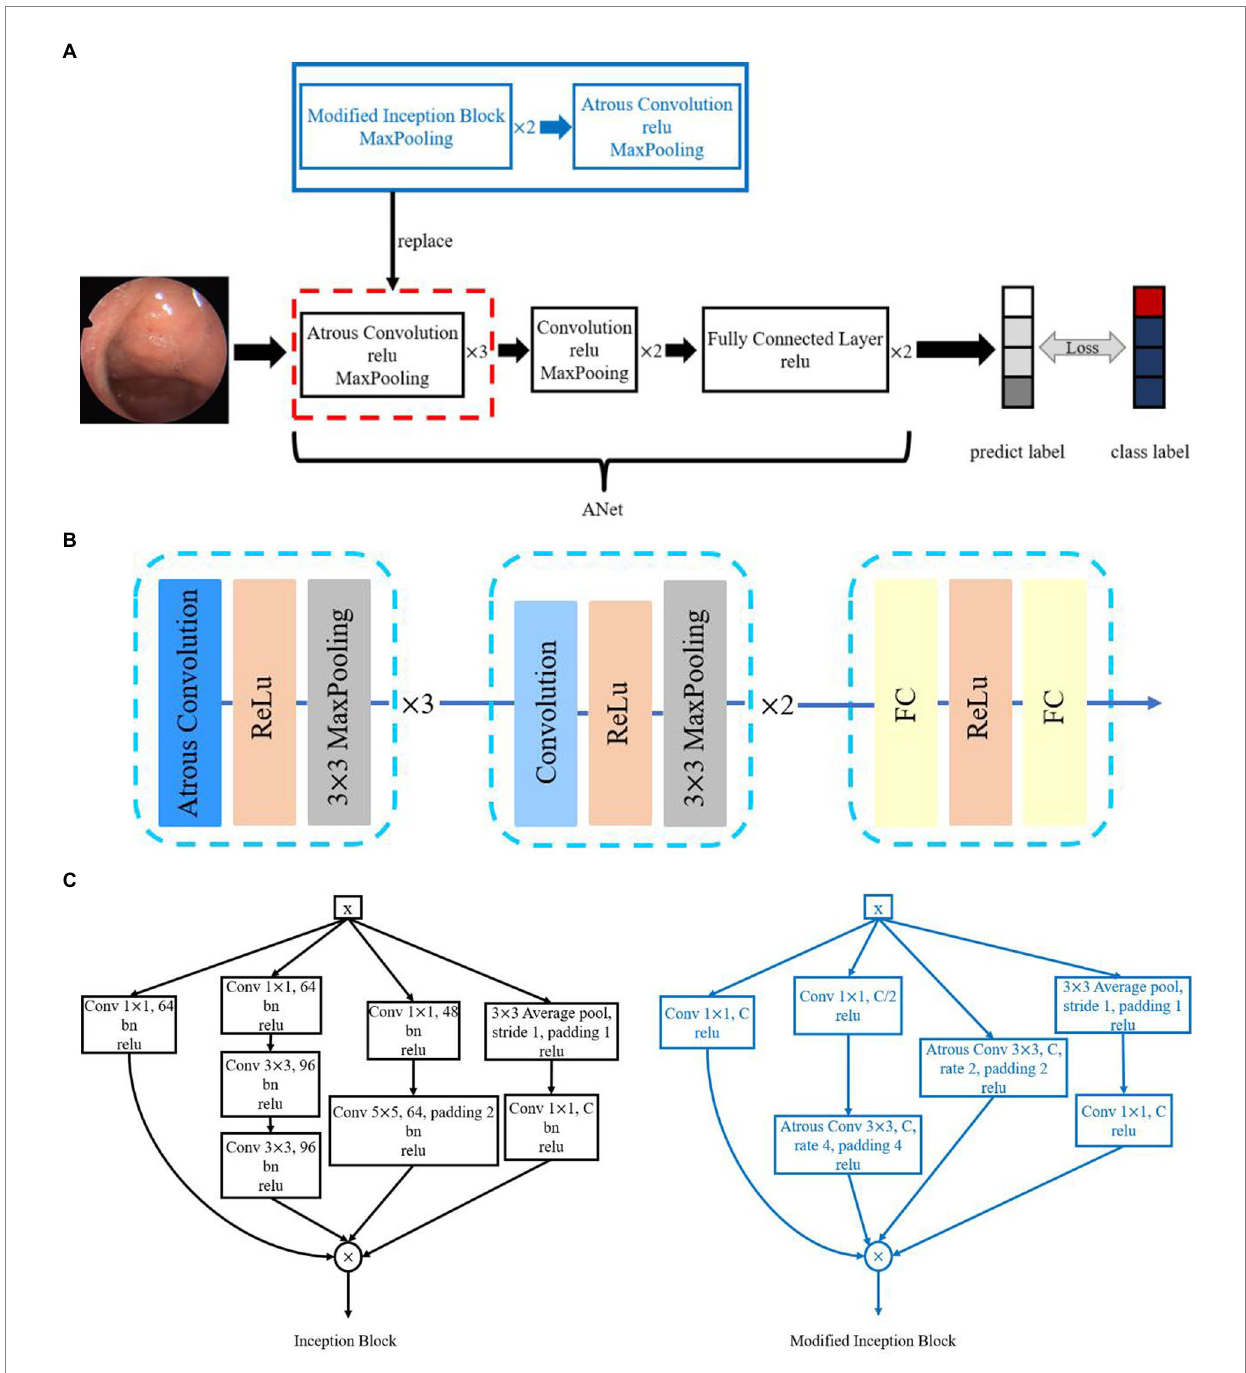
FIGURE 2 (A) The overview of the proposed MIB-ANet architecture. (B) The architecture of ANet. (C) The architecture of Inception Block and Modified Inception